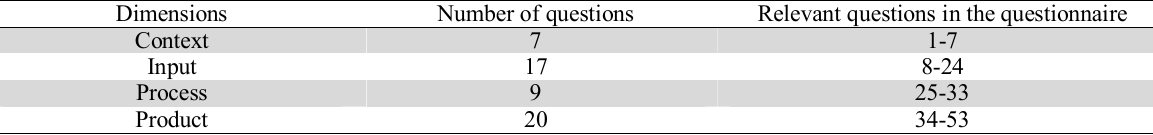
Dimensions and questions of the questionnaire